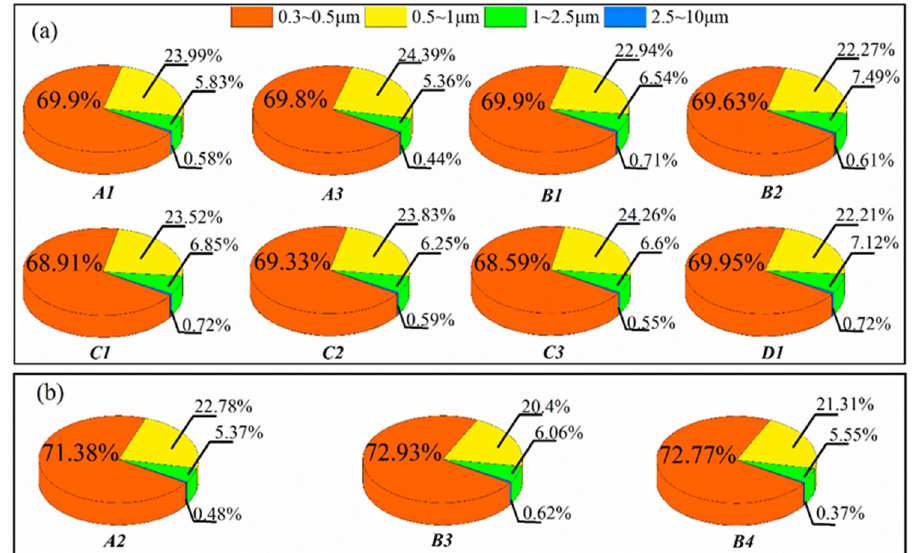
Figure 11. Proportion of four PM size ranges in smoke plumes in dyeing process (( a ) panel) and printing process (( b ) panel, A2 pigment printing, B3 and B4 digital printing) of four textile dyeing enterprises (A, B, C, D).